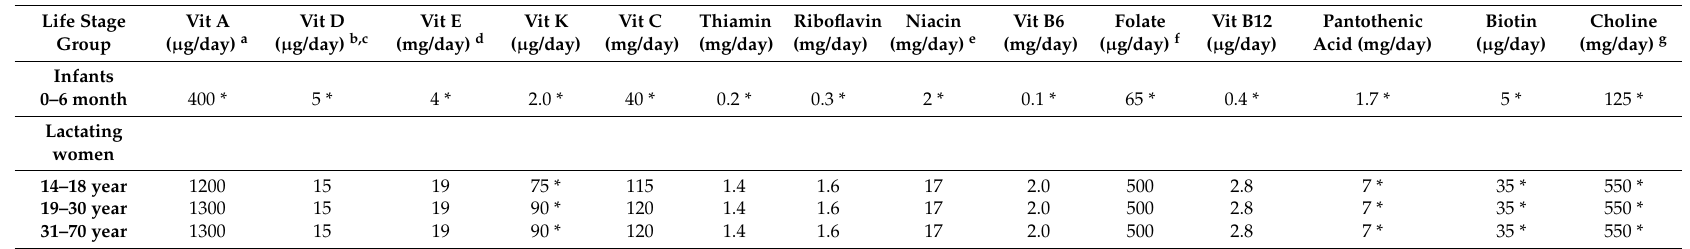
Table 1. Dietary Reference Intakes (DRIs): Recommended Dietary Allowances (RDA) and Adequate Intakes (AI) of vitamins during lactation and the first six months of life. Values as established by the Food and Nutrition Board, Institute of Medicine, National Academies,